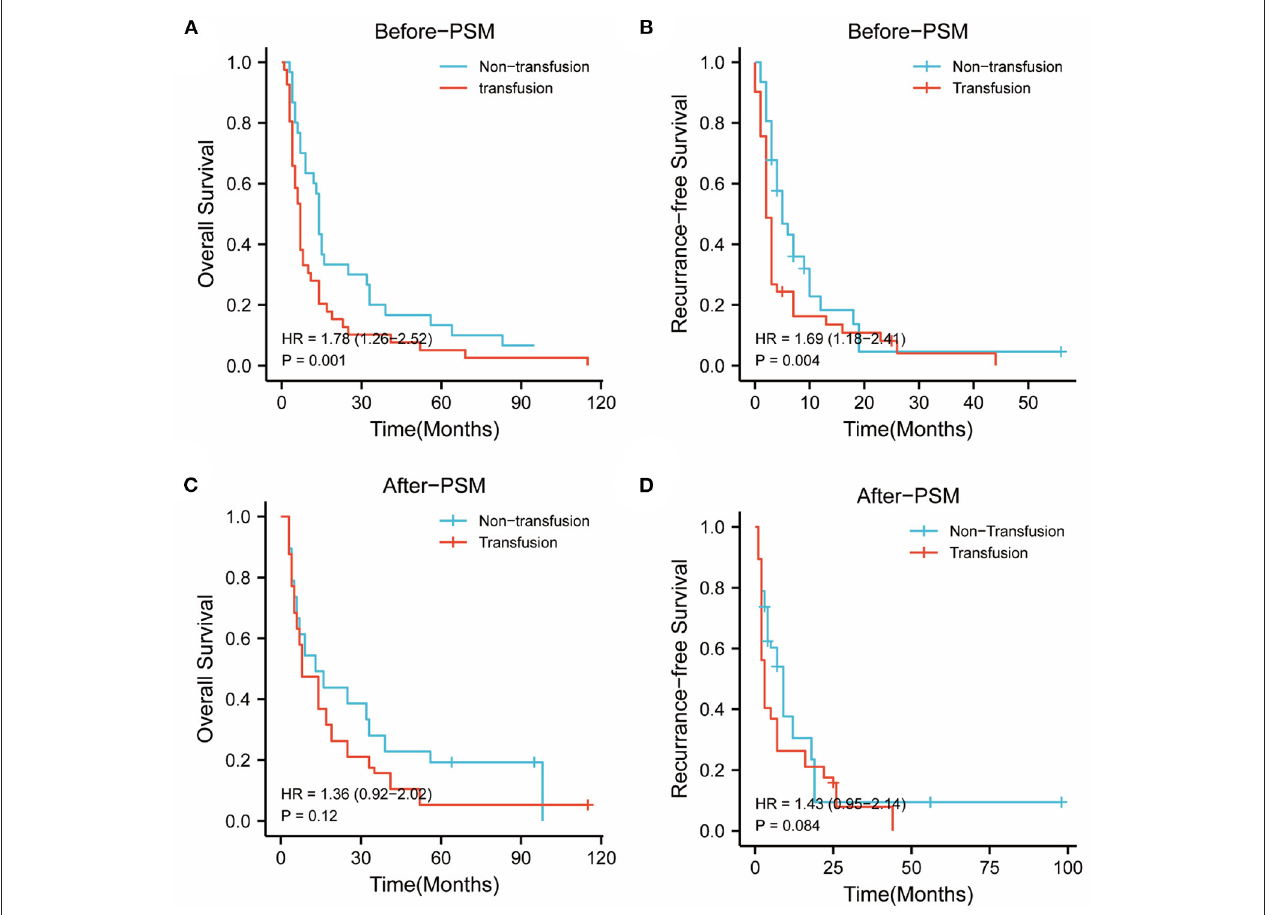
FIGURE 2 | The abscissa time unit is a month. Survival curves of patients with early-stage (BCLC B and C stages) tumors. (A) overall survival rates of the transfusion and nontransfusion groups before PSM ( p = 0.001). (B) Recurrence-free rates of the transfusion and nontransfusion groups before PSM ( p = 0.004). (C) OS survival rates of the transfusion and nontransfusion groups after PSM ( p = 0.120). (D) RFS rates of the transfusion and nontransfusion groups after PSM ( p =